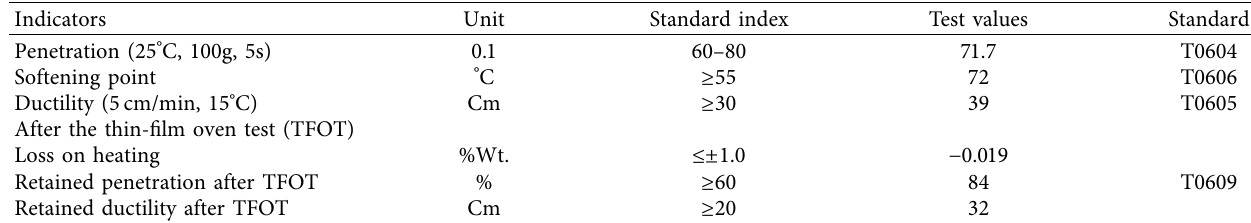
Table 3: Technical indexes of SBS asphalt.